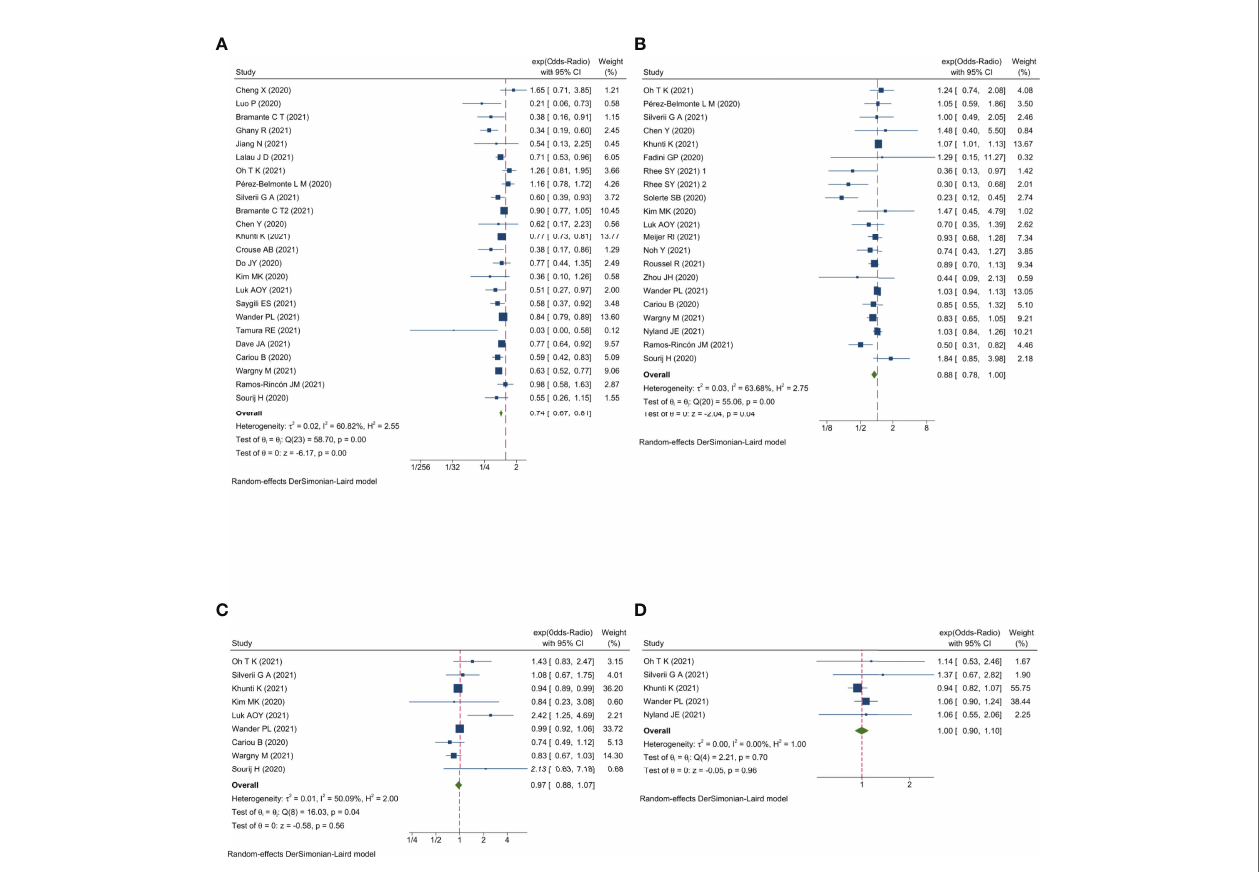
FIGURE 2 | Forest plot showing the association between antidiabetic agents use and mortality. (A) Metformin; (B) DPP4i; (C) Sulfonylurea; (D)